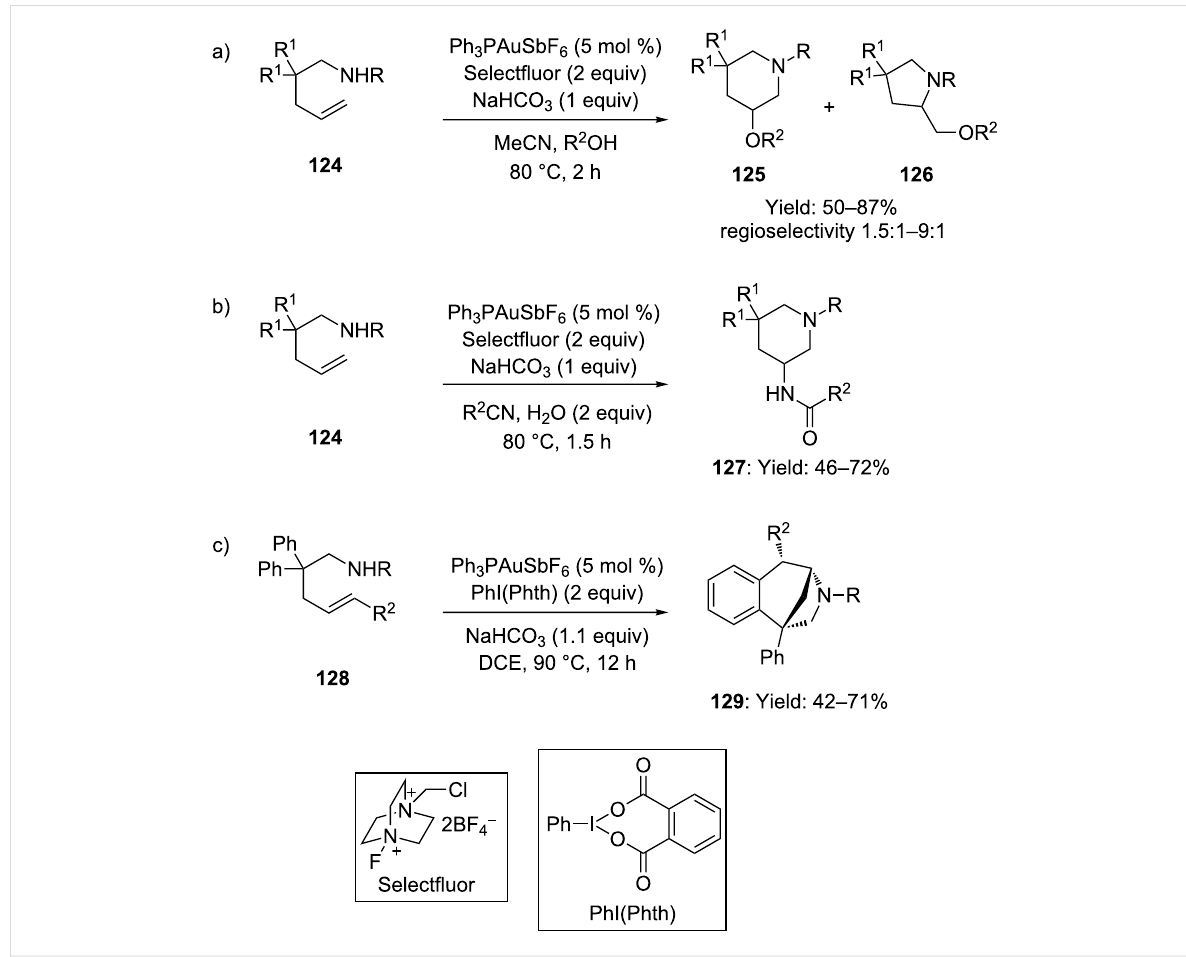
Scheme 32: Gold-catalyzed aminooxygenation and aminoarylation of alkenes.